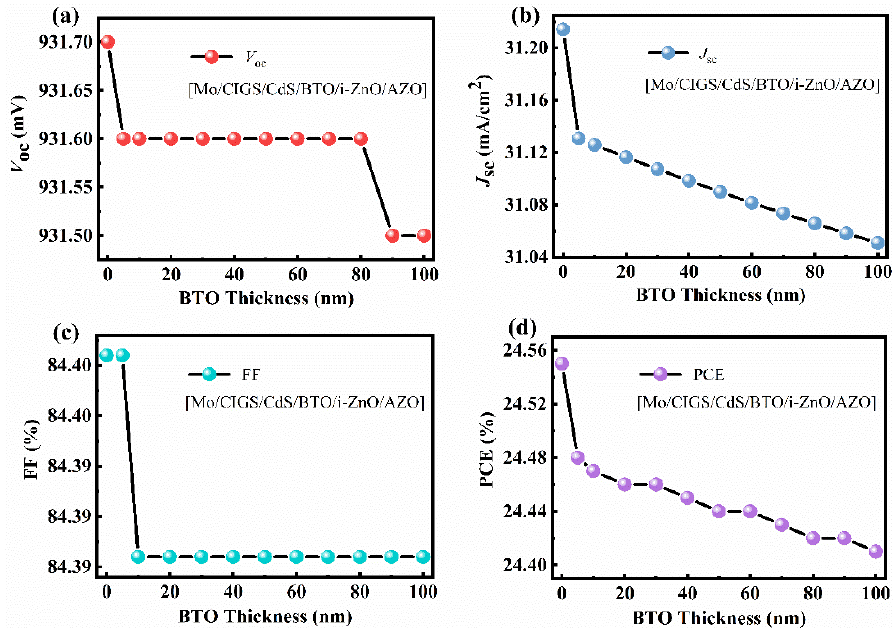
Figure 9. Effect of the BTO thickness on the ( a ) V oc , ( b ) J sc , ( c ) FF, and ( d ) PCE of the CIGS solar cell with a device structure of Mo/CIGS/CdS/BTO/i-ZnO/AZO.